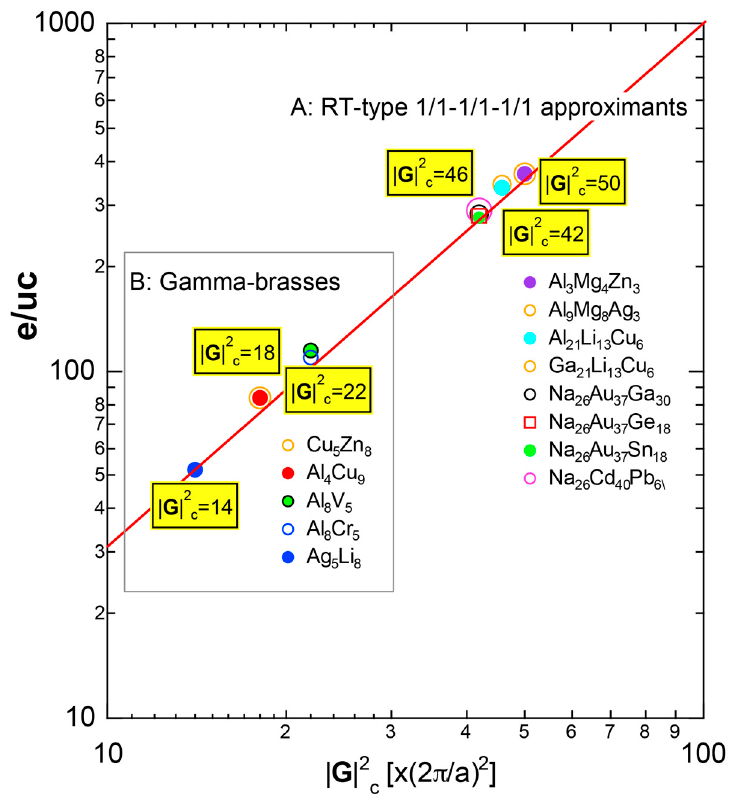
Figure 56. e/uc versus | G | 2 diagram on a log-log scale for RT-type 1/1-1/1-1/1 approximants in zone A and gamma-brasses in zone B [11]. They are classified into subgroups. The critical reciprocal lattice vector | G | 2 is expressed in units of { 2 π / a } 2 , where a is the lattice constant for cubic crystals. The 3/2-power law (red line) holds well, irrespective of subgroups involved.